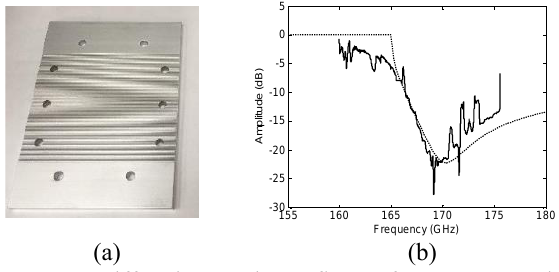
Fig. 10. Diffraction grating reflector for 63.5 mm miter bend (a). Measured and theoretical frequency response near 170 GHz (b).